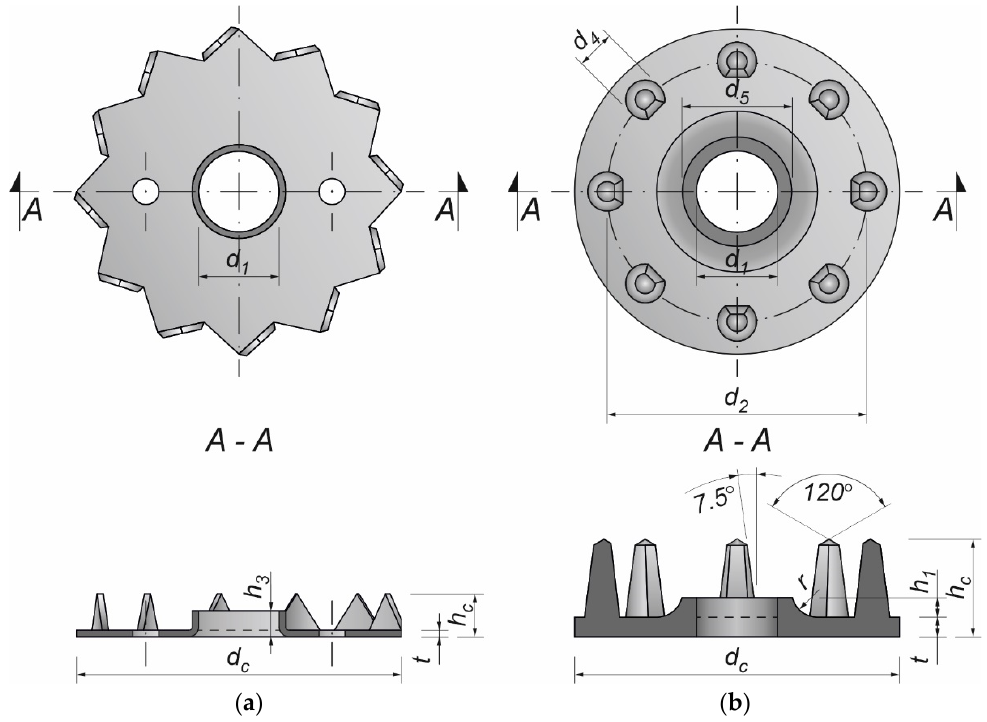
Figure 2. Toothed-plate connectors: ( a ) type C2, Bulldog; ( b ) C11, Geka. A toothed-plate connector (type C11-50/M12, Geka) is a single-sided connector made from a round plate with spikes on one side of the plate (see Figure 2b). The spikes are equidistant and are arranged in one circle. The toothed plate has a bolt-hole through its centre with a flange around the bolt-hole projecting from the same face as the spikes. The dimensions of the toothed plates used in this study are presented in Table 7. They were made of malleable cast iron EN-GJMB-350-10 (PN-JM 1130) according to EN 1562 [40] and galvanised (Fe/Zn12/C) to protect them from corrosion. Table 6. Dimensions of C2 (Bulldog) connectors 1,2